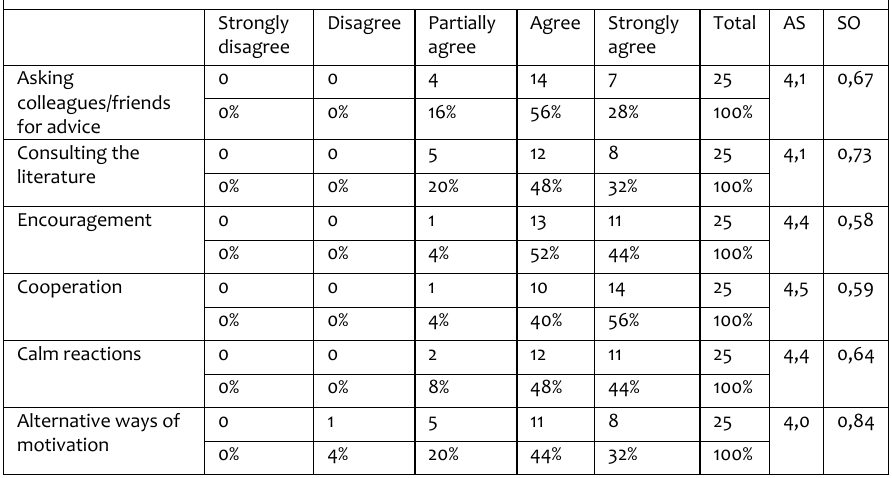
Table 2: The display of answers from the second stage of the research regarding the preschool teachers’ own self-regulated learning at the